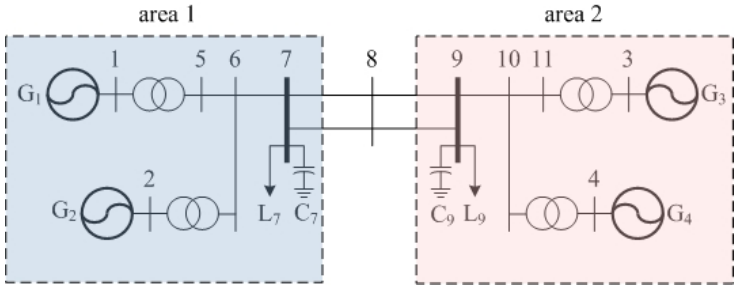
Figure 7. Two-area systems (Case 1: 50 MW; and Case 2: 400 MW).